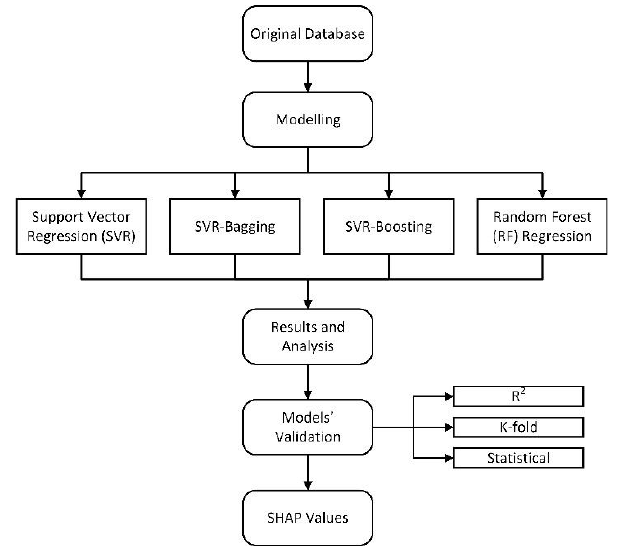
Figure 2. Flow chart of research strategy.